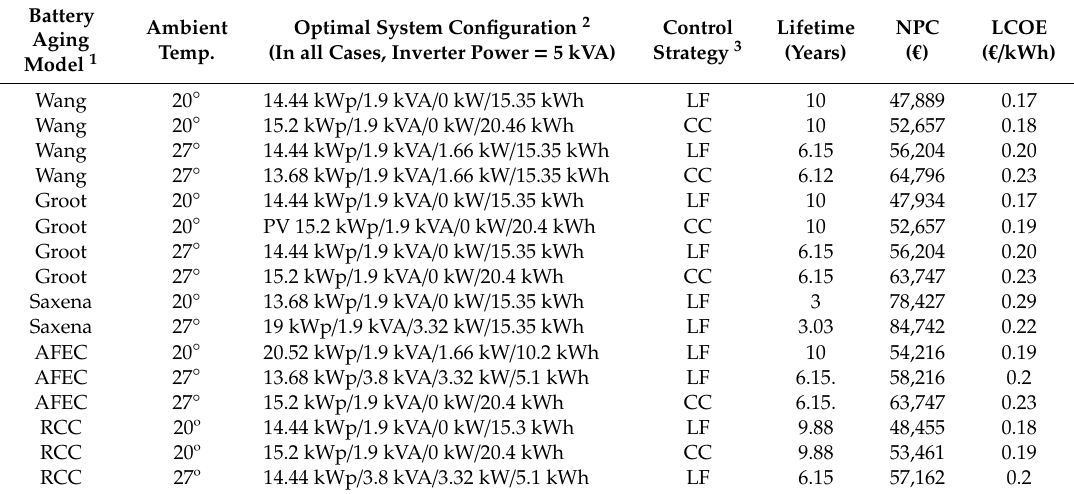
Table 12. Results of the optimizations for the case of lithium batteries, using the three models of battery life and with two different average ambient temperature values (20 °C or 27 °C).